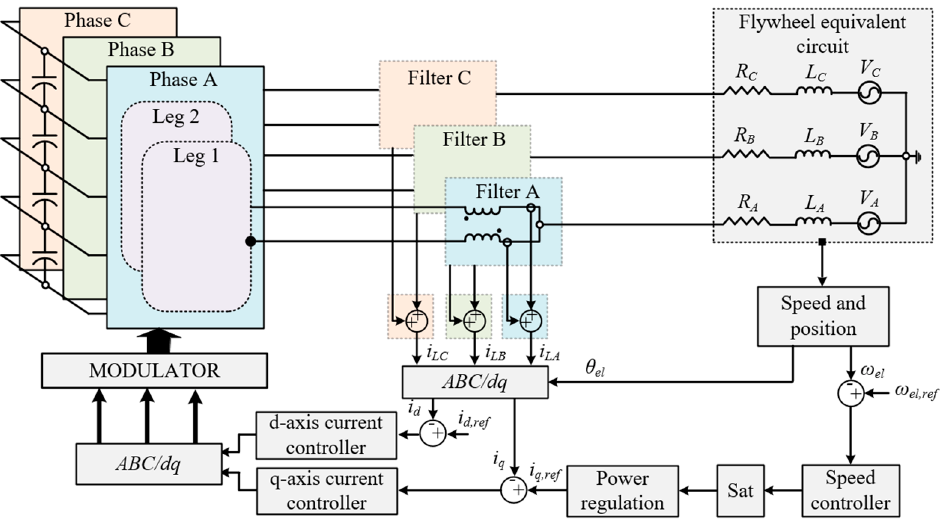
Figure 10. Block scheme of the 3 Φ 5L E-Type Inverter control algorithm for the flywheel energy storage system.